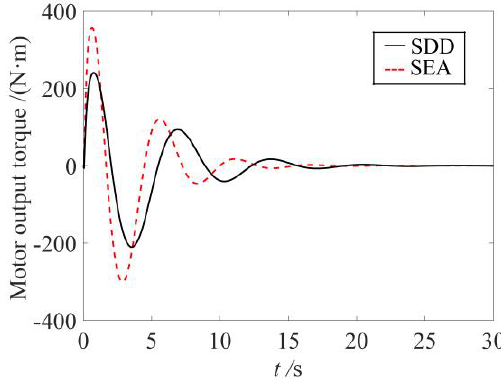
Figure 5. 1st joint motor output torque.